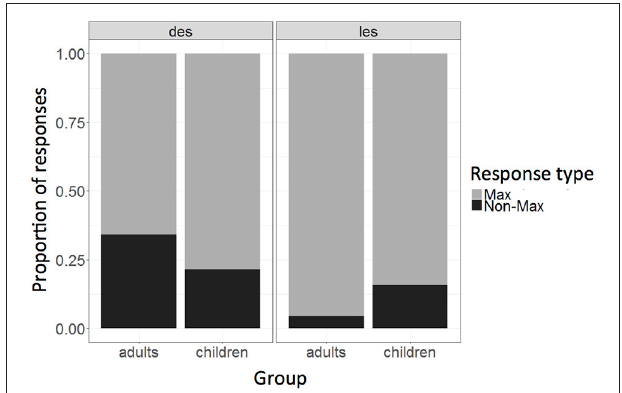
FIGURE 2 | Proportion of response types (maximal vs. non-maximal) by GROUP (adults vs.children) and DEFINITENESS ( des , indefinite plural, vs. les , definite